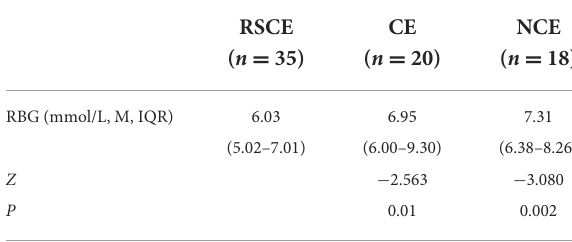
TABLE 3 Comparison of random blood glucose levels between